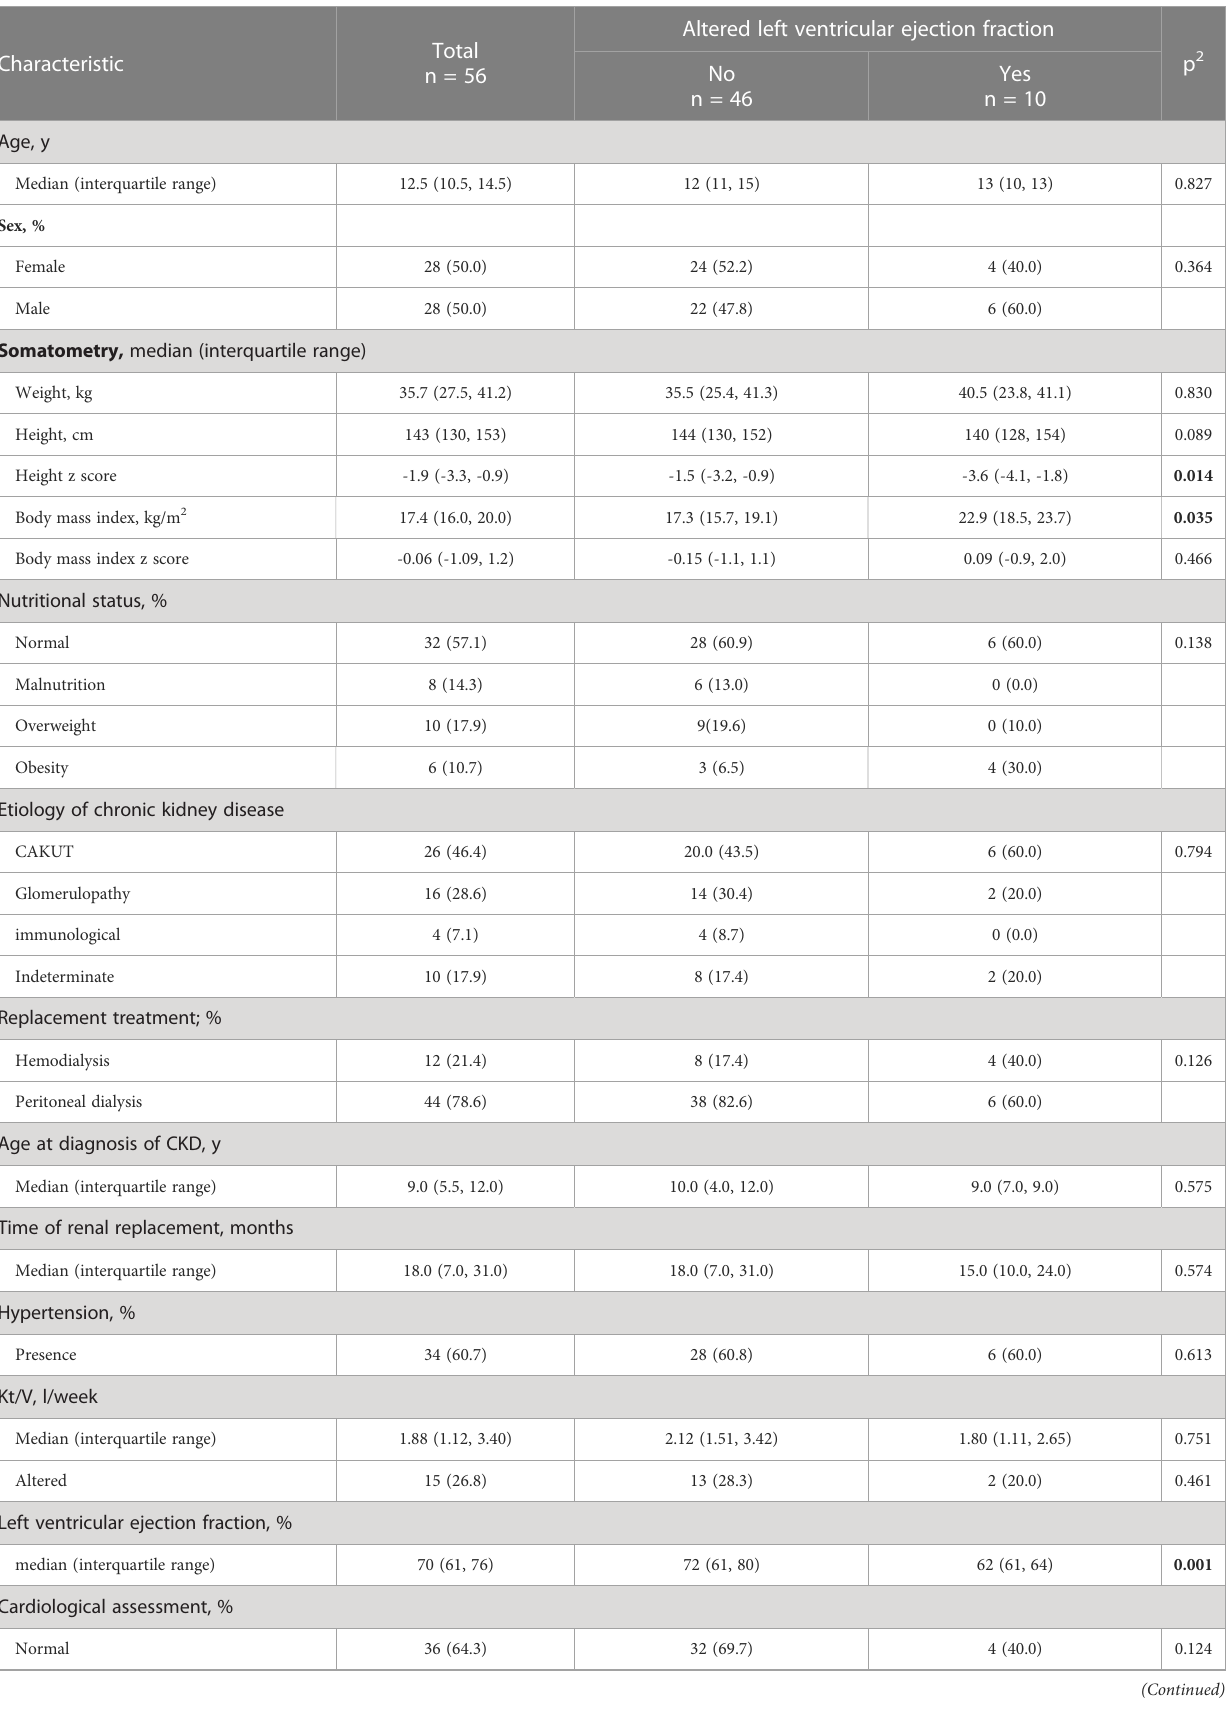
TABLE 1 Baseline in CPK pediatric patients ’ characteristics, strati fi ed by altered left ventricular ejection fraction 1 .